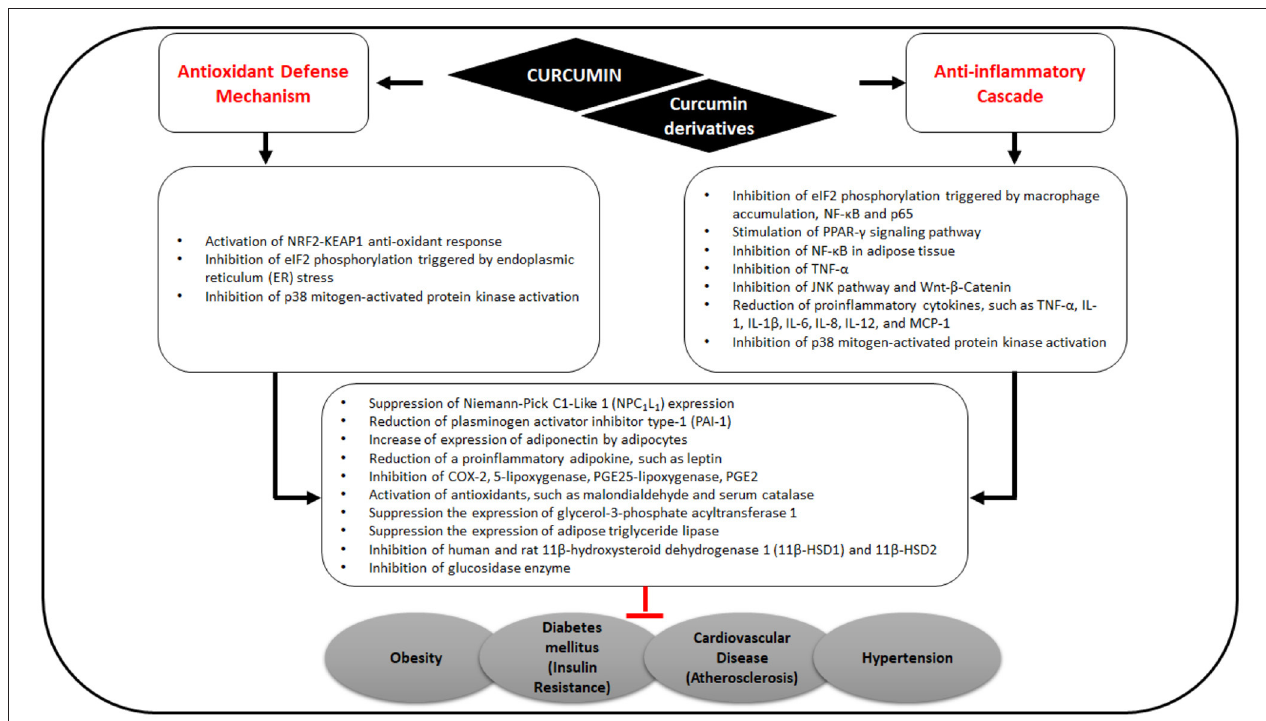
FIGURE 3 | Effects of curcumin on antioxidant defense mechanisms and anti-inflammatory cascade related to